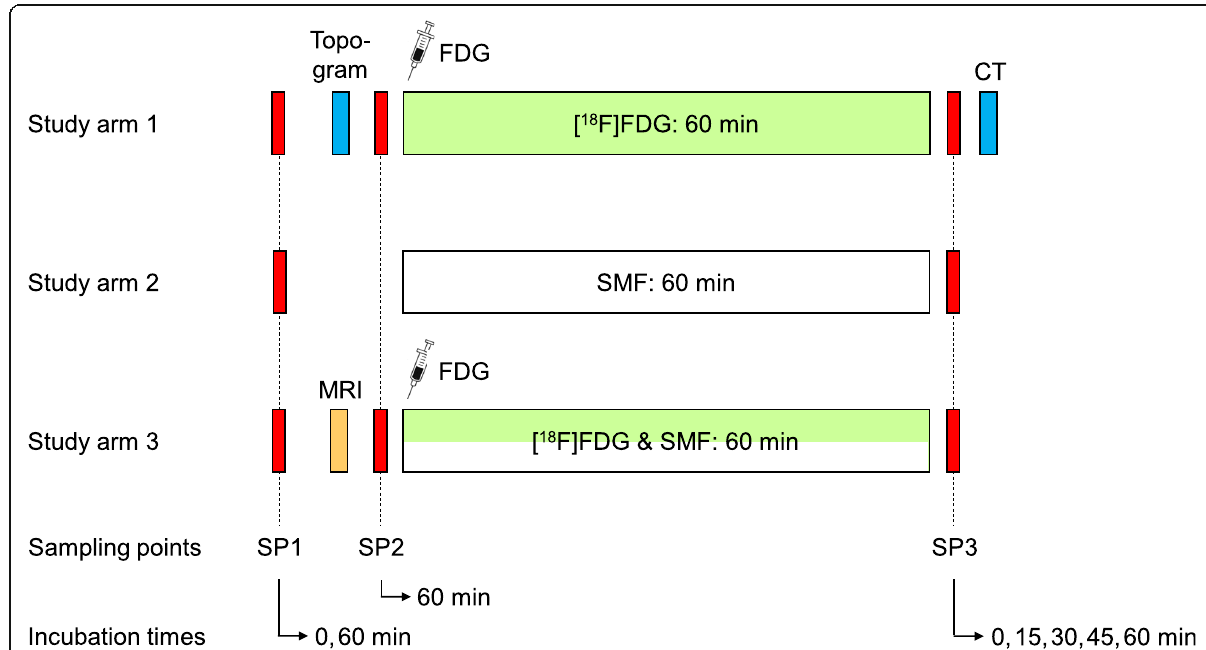
Fig. 2 Design of the three-armed study indicating the investigated exposure scenarios as well as the blood sampling and incubation